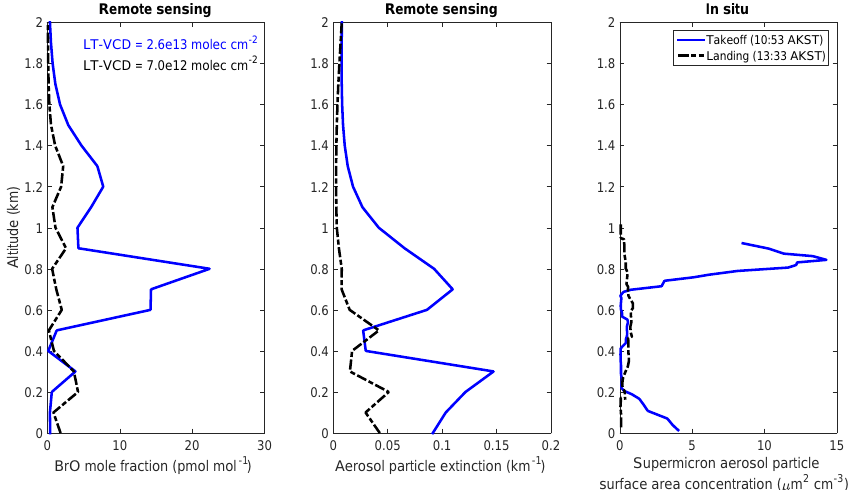
Figure 9. Vertical profiles of BrO mole fractions with the corresponding LT-VCD, aerosol particle extinction, and supermicron (1–4µm optical diameter) aerosol particle surface area concentrations during takeoff and landing for the 13 March 2012 flight. Error bars on the remote sensing measurements have been omitted for clarity and are shown in the Supplement.